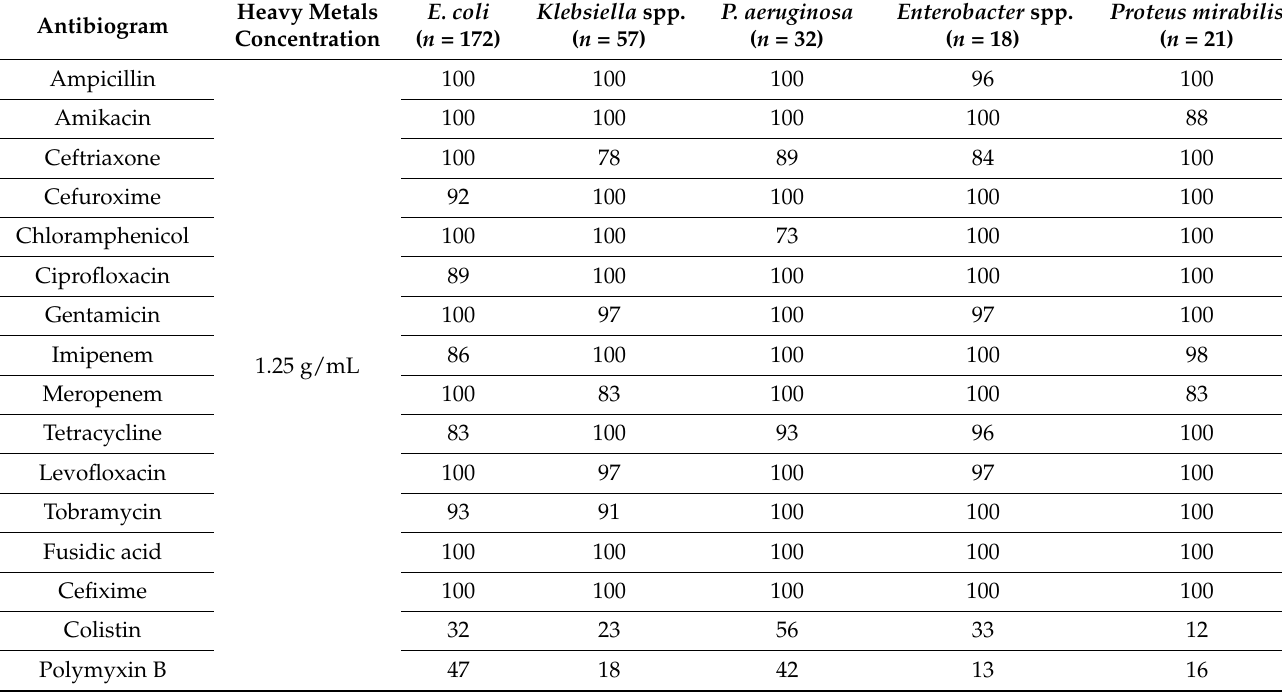
Table 3. Heavy metals (Arsenic) induced resistance against the CLSI-approved ESBL antibiogram